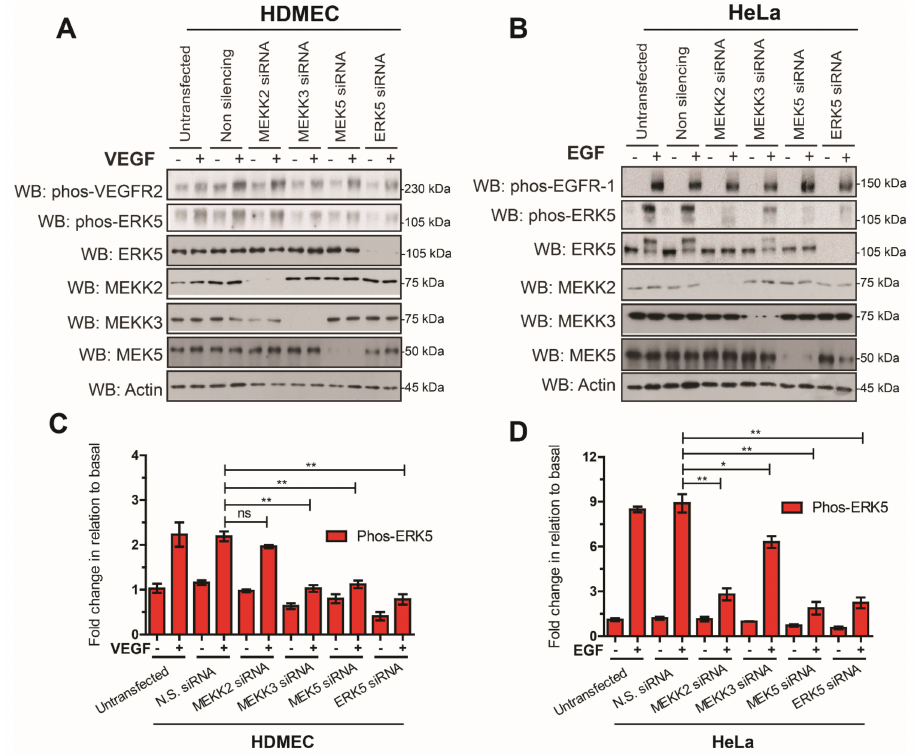
Figure 3. Analysis of the canonical ERK5 signalling axis in HDMECs and HeLa cells. ( A ) HD- MECs or ( B ) HeLa cells were transfected with siRNA duplexes (10 nM) targeting MEKK2, MEKK3, MEK5, and ERK5 or non-silencing (N.S.) siRNA. Then, 24 h after transfection, cells were